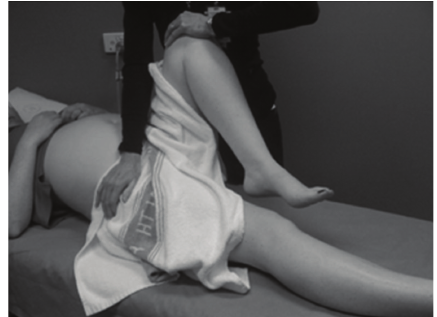
Figure 6: The posterior pelvic pain provocation test.